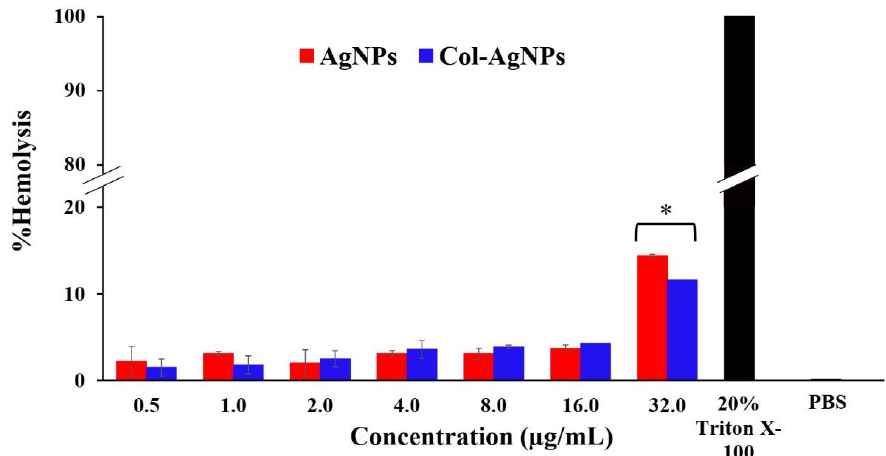
Figure 10. Hemolysis assay for nanoparticles . The human red blood cells were incubated with and Col-AgNPs. 20% Triton-X 100 and phosphate-buffered saline (PBS) were used as the positive AgNPs and Col - AgNPs . 20 % Triton - X 100 and phosphate-buffered saline ( PBS ) were used as the positive and negative controls, respectively . * indicated a significant difference at p - value < 0 . 05 . and negative controls, respectively. * indicated a significant difference at p -value <